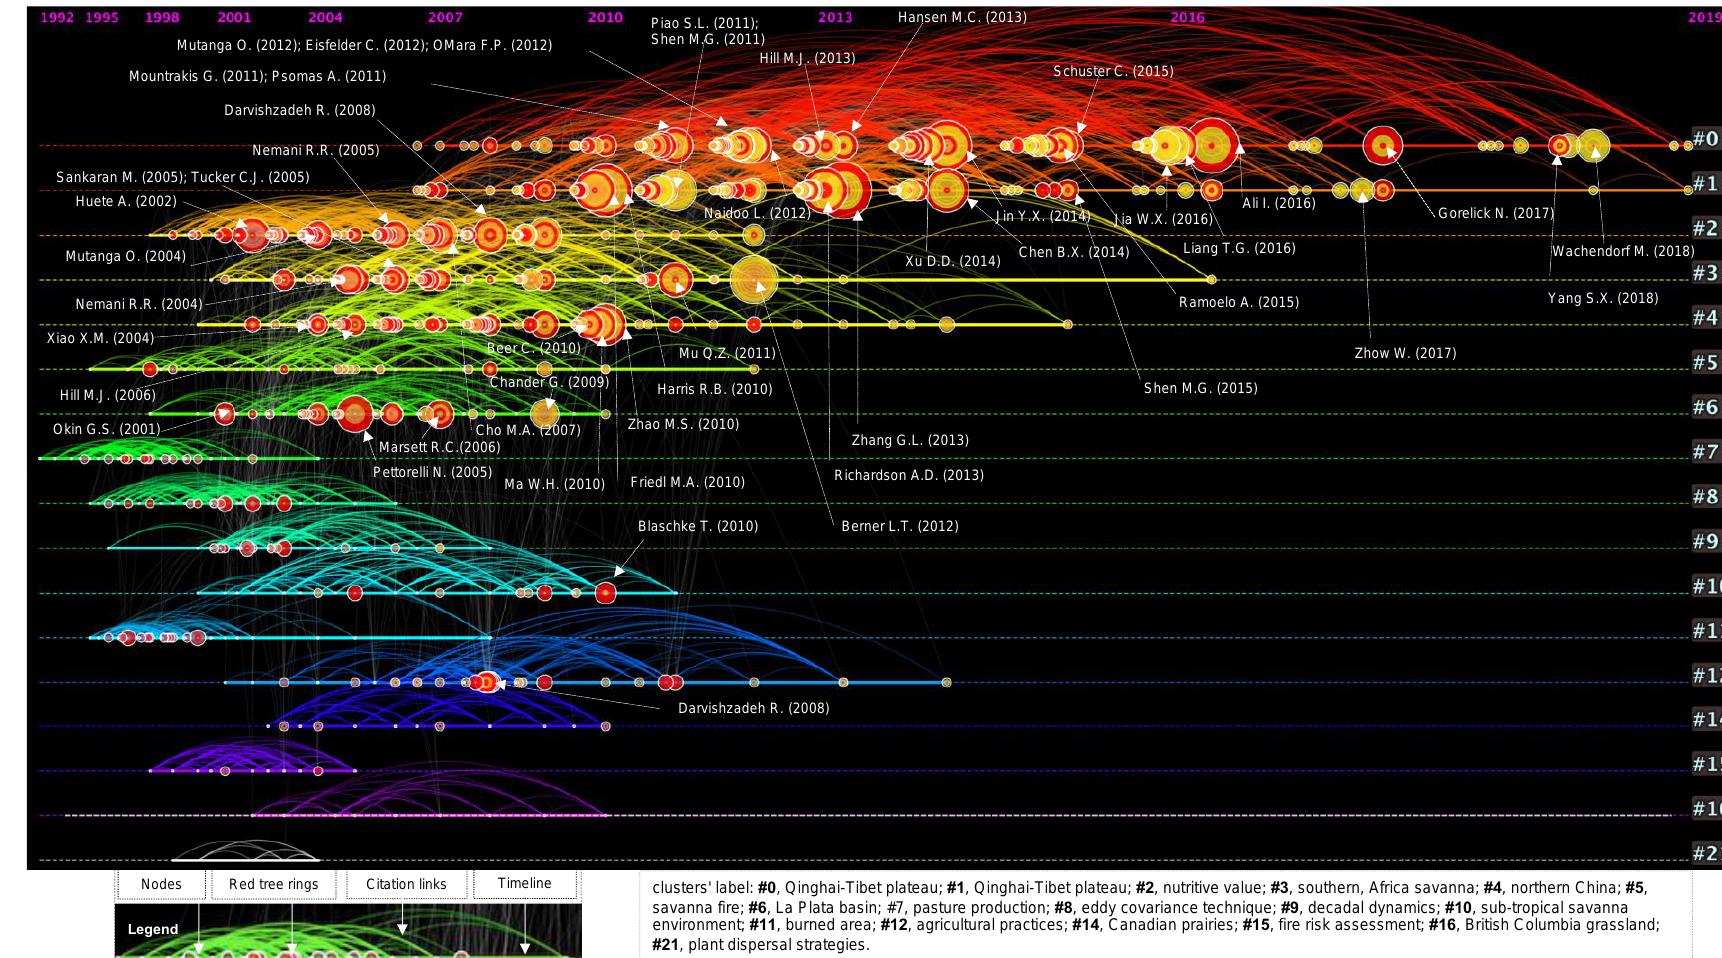
Figure 7. Visualization of clusters in terms of timeline view of the document co-citation analysis (DCA) in GRS research from 1980 to 2020. The horizontal axis represents the year, each node represents a popular cited reference, and the size of each node is proportional to its cited frequency, red tree rings mean the burst. The line between each node represents the temporal evolution of the cited reference, and the line thickness represents the co-citation strength; these lines reflect the relationship between transfer and inheritance among cited references [32,33,36].